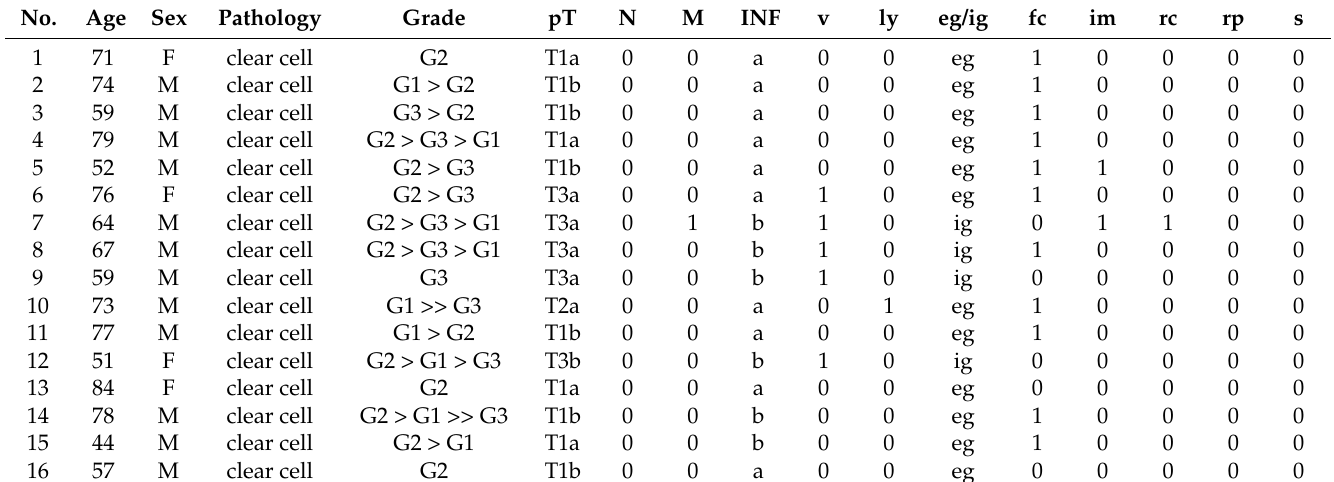
Table 1. Characteristics of patients with clear cell renal cell carcinoma